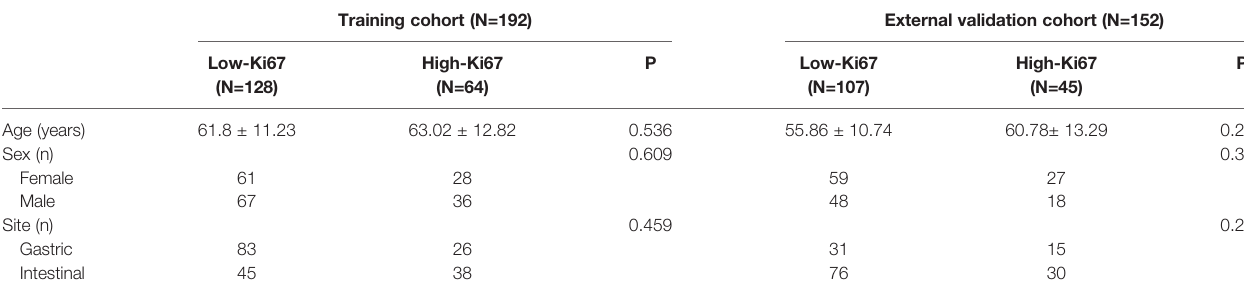
TABLE 1 | Patient characteristics in the training and external validation